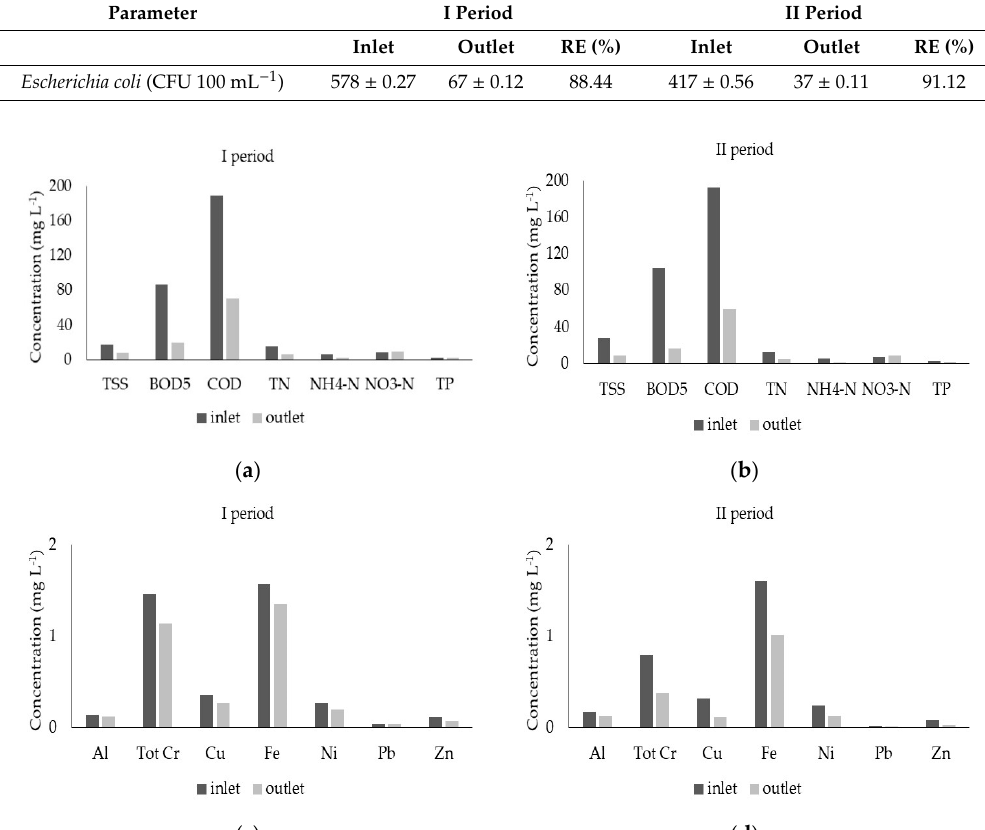
Table 3. Escherichia coli concentration levels of the FFSW from the inflow and outflow of the VSSFs CW. Removal efficiency from October 2018 to July 2019. Average values (±standard deviation) are shown ( n = 18).